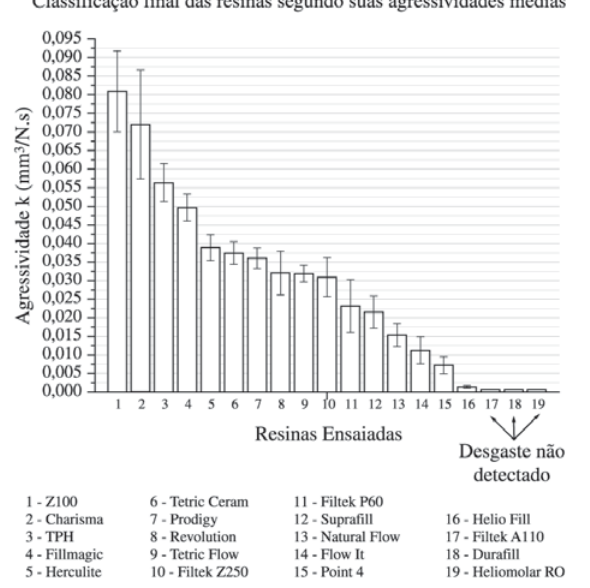
Figura 7. Gráfico com a classificação final das 19 resinas com- postas ensaiadas em função de suas agressividades